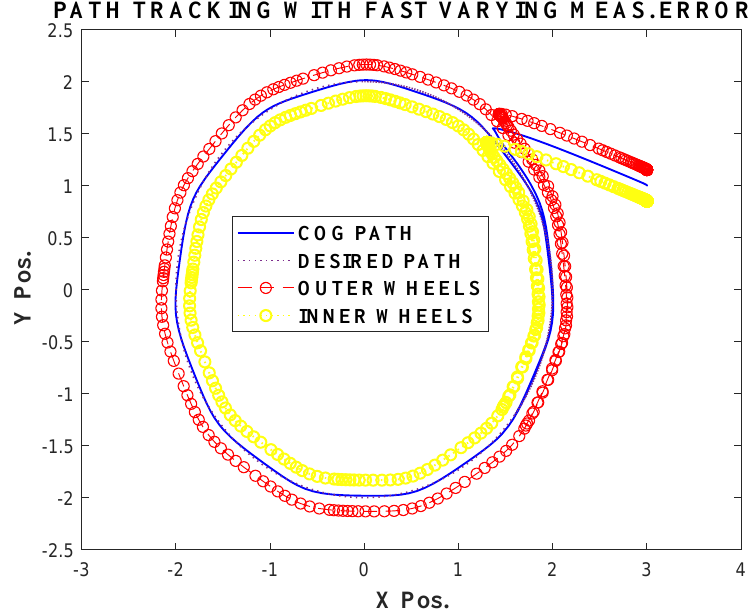
Figure 9. Circular path tracking with fast varying measurement errors.